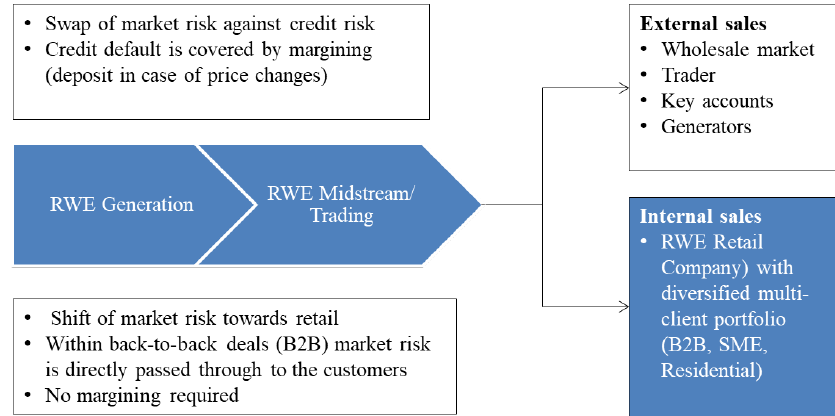
Figure 14. Overview of the main synergies between “midstream/trading”, generation, and retail. Own illustration, based on RWE internal information.